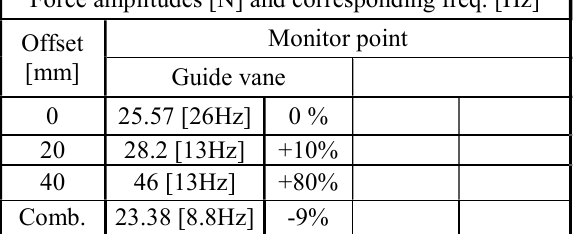
Table 6 The overview of maximum static pressure amplitudes in